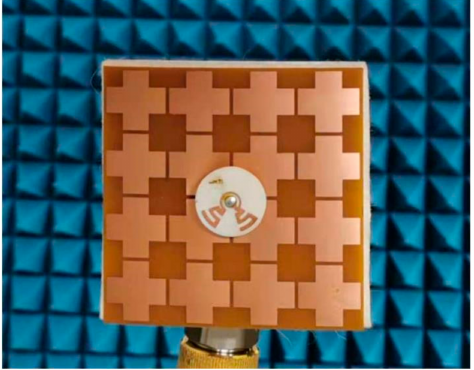
Figure 8. The prototype of the proposed antenna sensor.